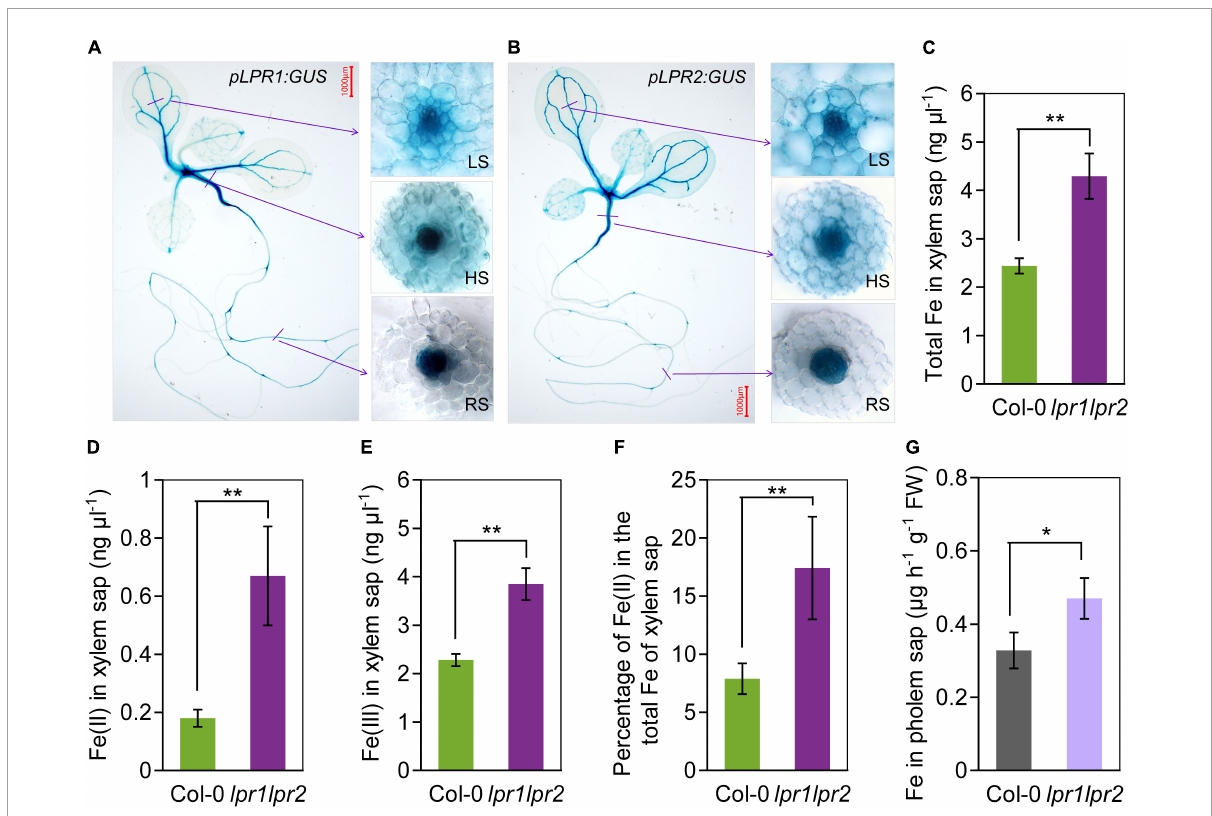
FIGURE2 LPRs are expressed in vascular and involved in Fe(II) oxidation in xylem. (A,B) Histochemical β -glucuronidase (GUS) staining of transformants pLPR1:GUS /Col-0 and pLPR2:GUS /Col-0. Cross sections of leaf major veins (LS, leaf section), hypocotyls (HS, hypocotyl section), and roots (RS, root section) are in the right inset. The 7-day-old seedlings grown in Fe-sufficient nutrient solution were used for analysis. The total Fe (C) , Fe(II) (D) , and Fe(III) (E) concentration in the xylem saps of Col-0 and lpr1lpr2 . (F) Percentage of Fe(II) in total Fe of xylem saps of Col-0 and lpr1lpr2 . (G) Fe concentration in the phloem saps of Col-0 and lpr1lpr2 . Plants were precultured in low-Fe (0.2 µ M) nutrient solution for 3 weeks and transferred to Fe-sufficient (50 µ M) nutrient solution for another 2 weeks, and then, the xylem saps and phloem saps were collected. Values are means ± SD of three replicates. Asterisks indicate a significant difference at * P < 0.05, ** P < 0.01, by Tukey’s test. n.s., no significance. Scale bars 1,000 µ